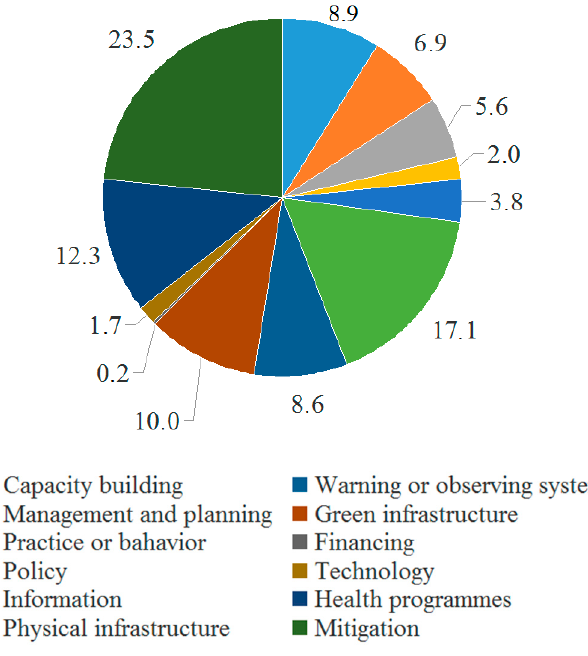
Figure 2. Share of individual types of measures (in %) in the total number of actions in the MAPs of selected cities in Poland up to 2030.